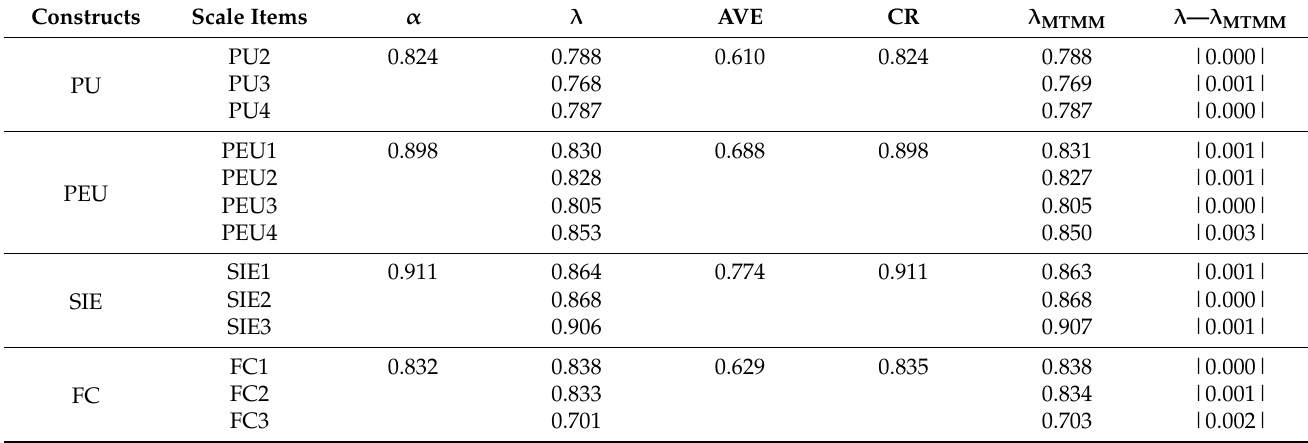
Table A2. Construct